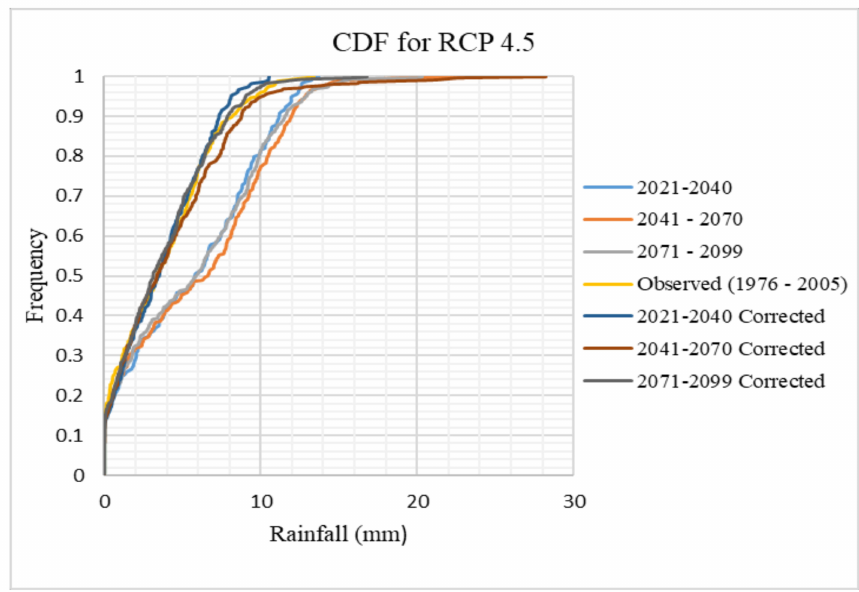
Figure 3. The CDFs of projected daily rainfall under Representative Concentration Pathway (RCP) 4.5 before and after bias correction.